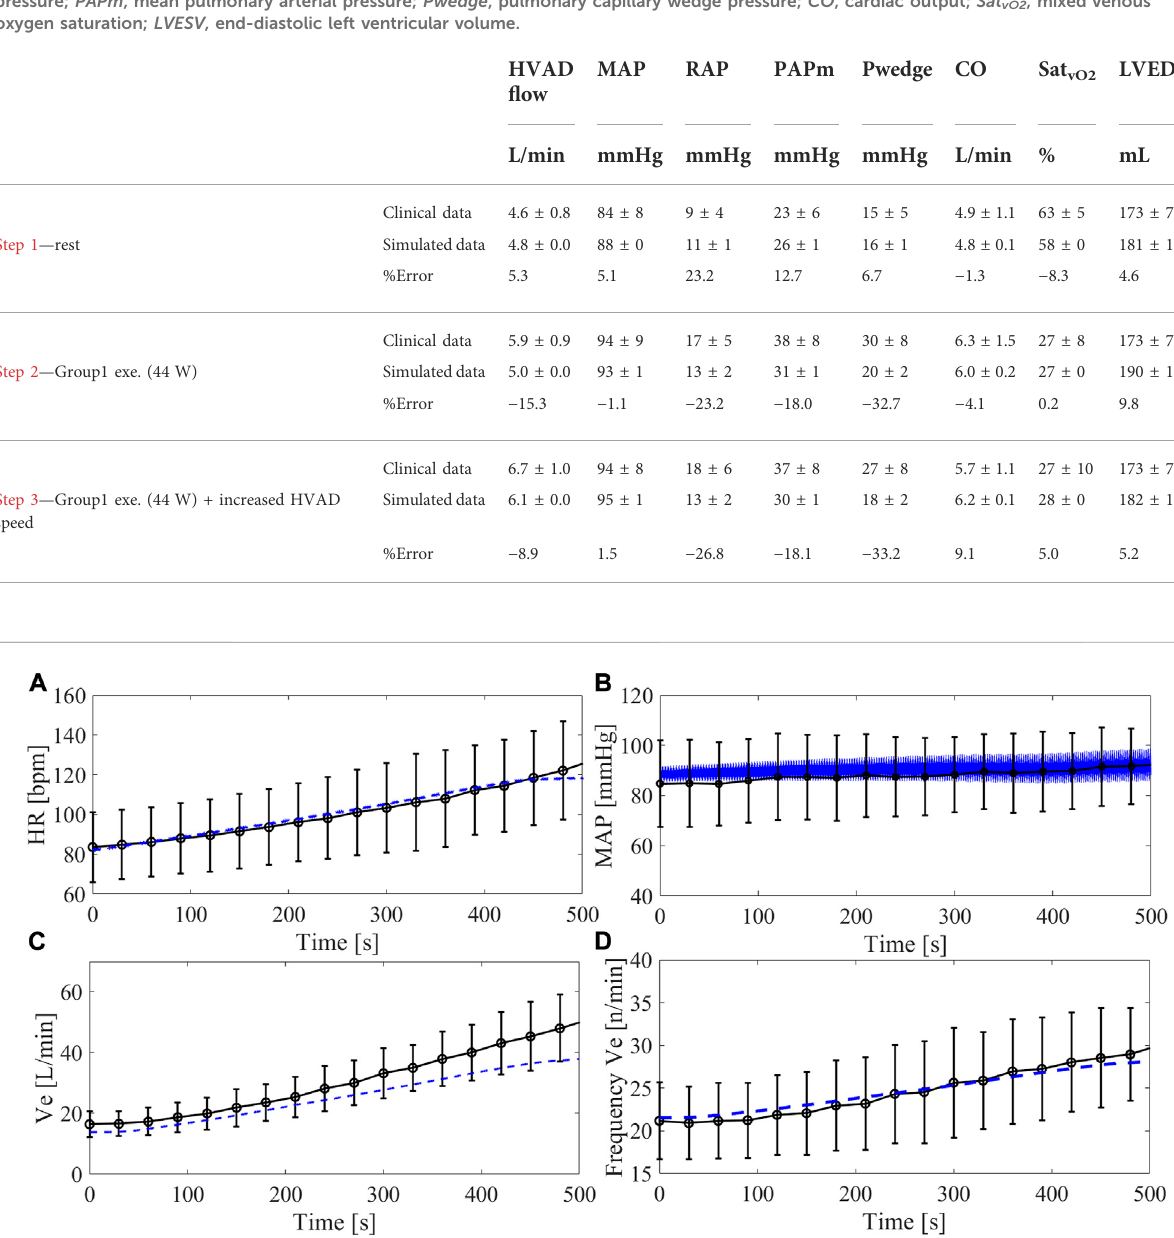
TABLE 2 Comparison between simulated data and clinical data of the 14 HVAD patients of Group1: MAP , mean arterial pressure; RAP , right atrial pressure; PAPm , mean pulmonary arterial pressure; Pwedge , pulmonary capillary wedge pressure; CO , cardiac output; Sat vO2 , mixed venous oxygen saturation; LVESV , end-diastolic left ventricular volume.